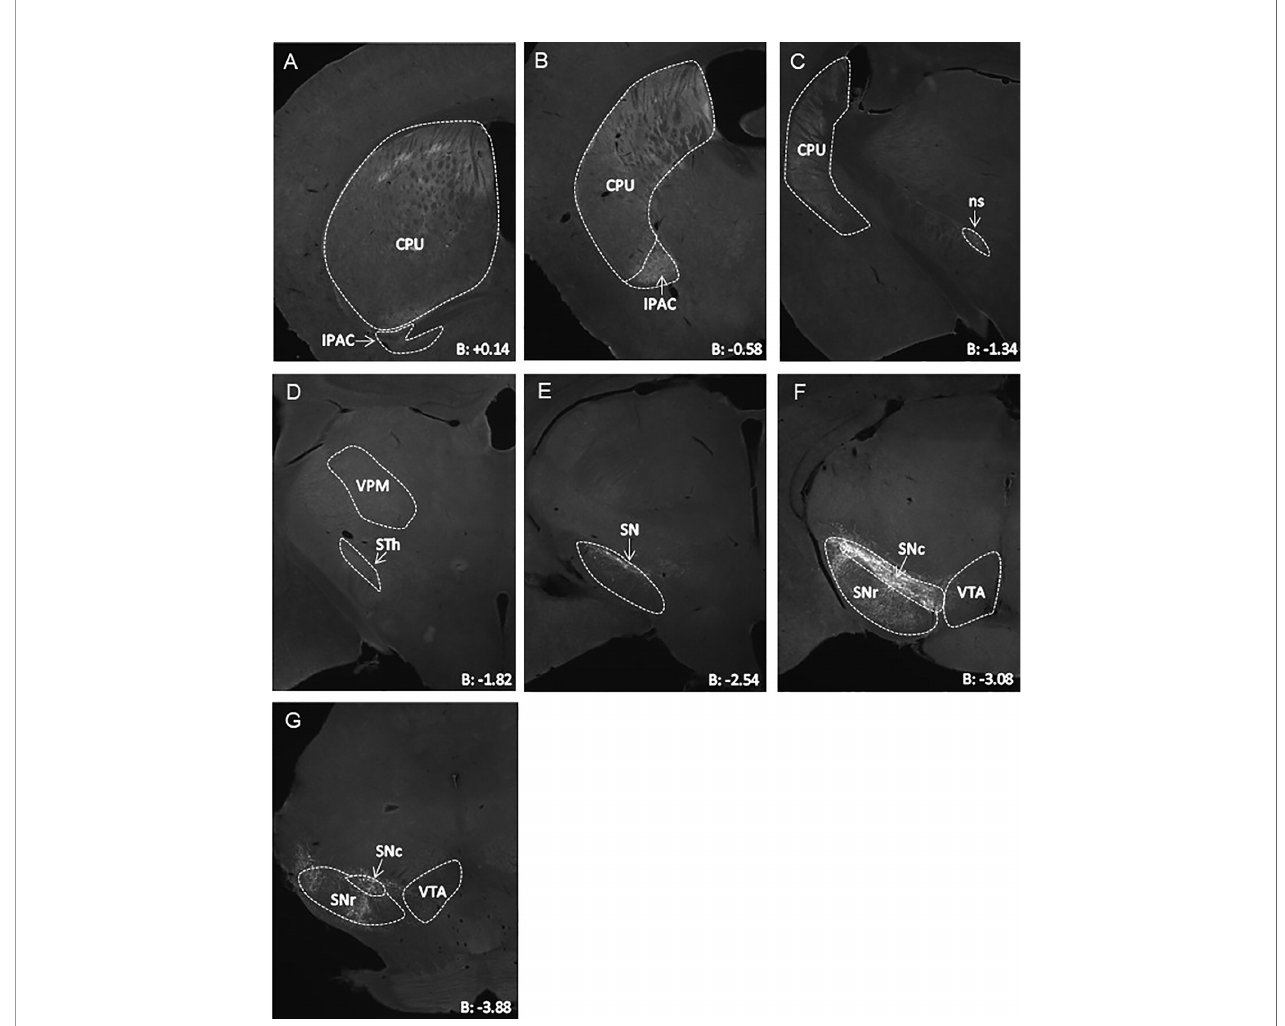
FIGURE 3 | Representative AAV-DIO-ChR2-eYFP tracing of projections from SN LepR neurons in LepR-cre mice (n=4). (A – G) eYFP expression in CPU ++, IPAC ++, STh +, VPM + and VTA +/- to which SN LepR neurons sent detectable projections (++ strong eYFP, + eYFP present, +/- scarce eYFP). In (E – G) , eYFP soma and tracks within the SN. B = bregma; CPU, caudate putamen; IPAC, interstitial nucleus of the posterior limb of the anterior commissure; ns, nigrostriatal bundle; SN, substantia nigra; SNc, SN pars compacta; SNr, SN pars reticulate; STh, subthalamic nucleus; VPM, Ventral posteromedial thalamus; VTA, ventral tegmental